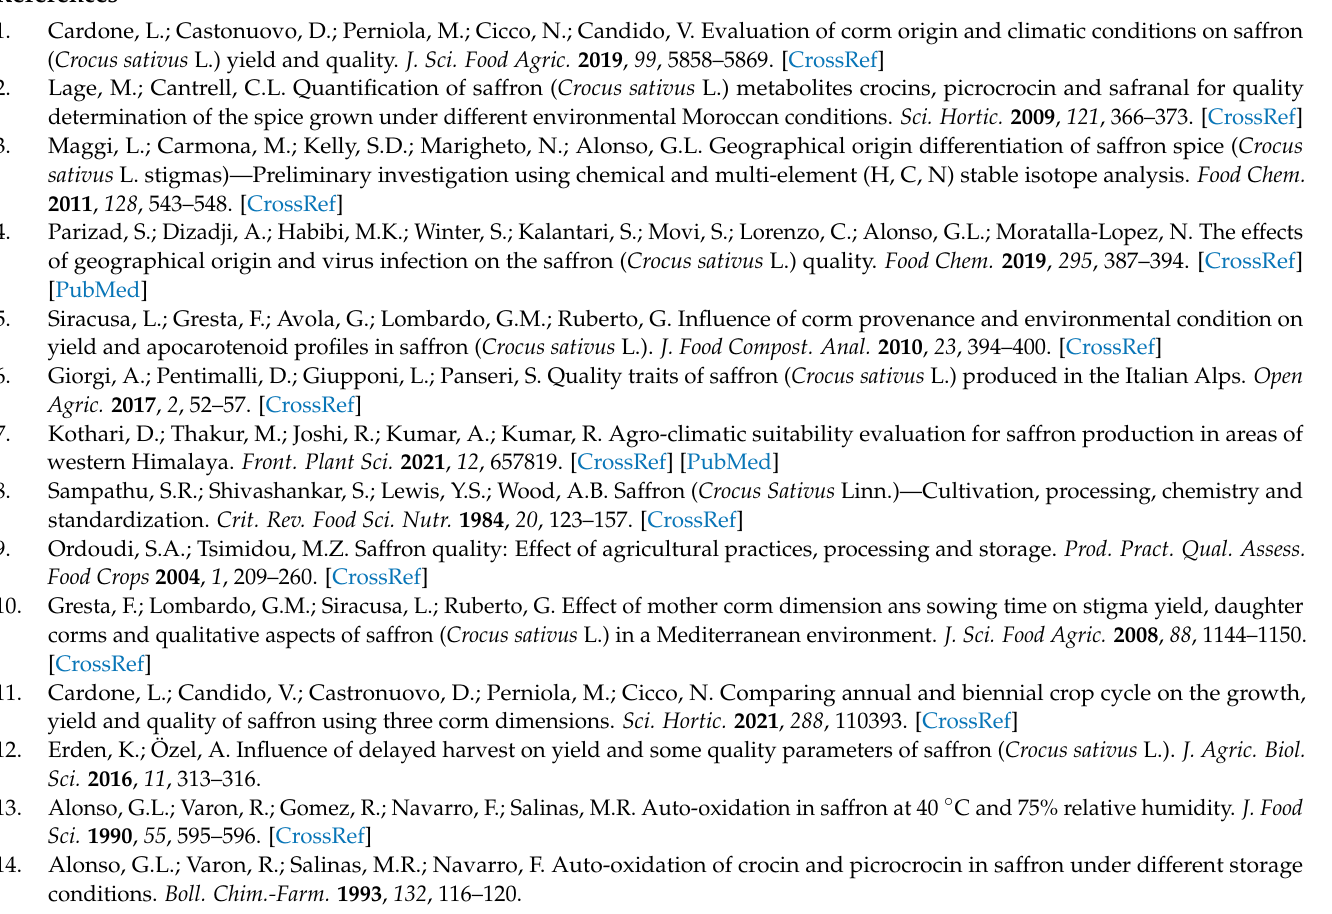
Figure B2. Diffractogram of X-rays on oriented blades of the T1 sample. Figure A3. Diffractogram of X-rays on oriented blades of the T1